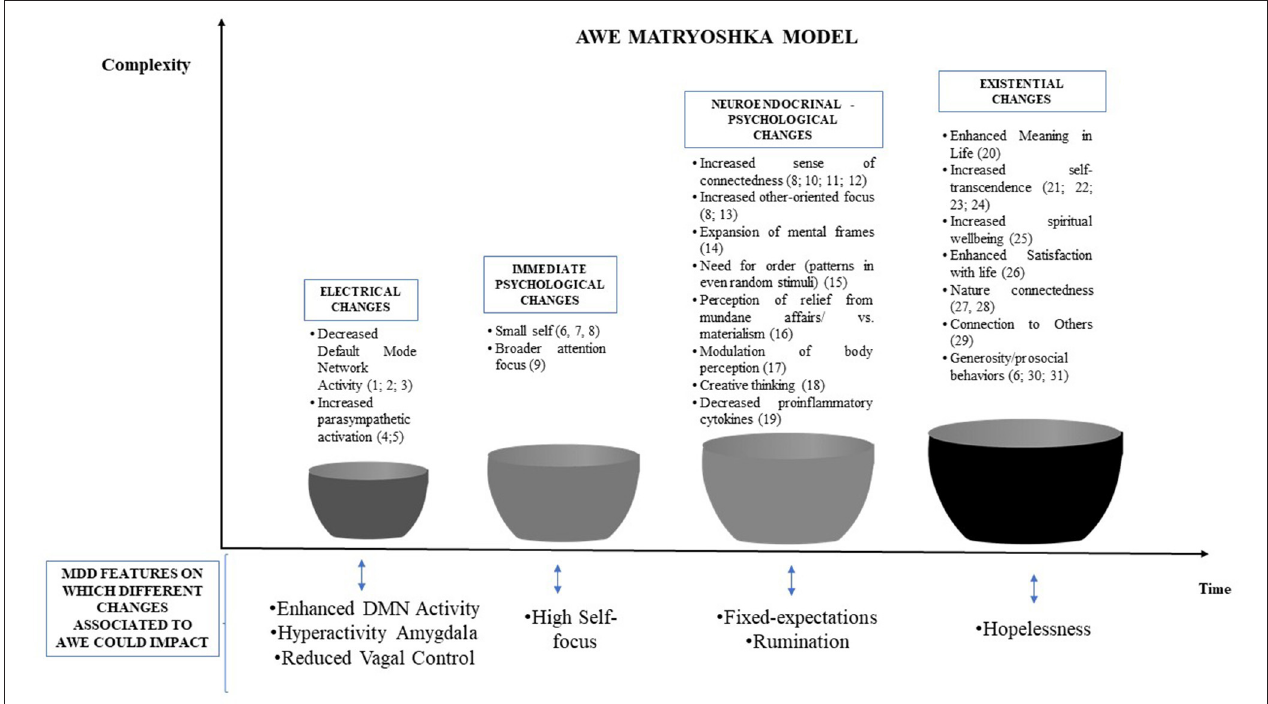
FIGURE 2 | Synthesis of the potential connections between awe and